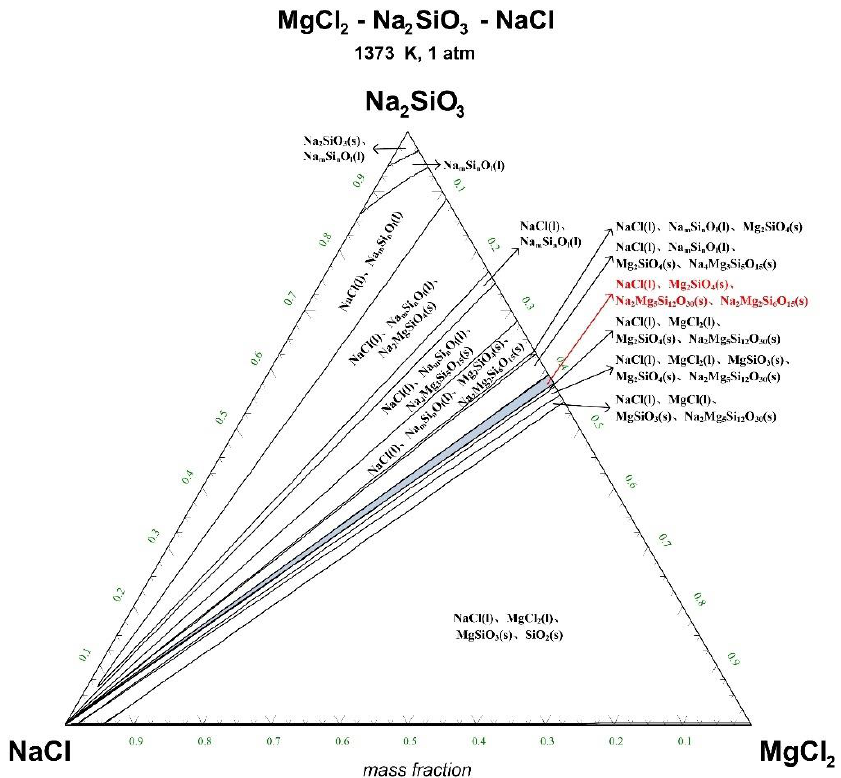
Figure 7. Ternary phase diagram of MgCl 2 -Na 2 SiO 3 -NaCl system at 1373 K. (l — liquid; s — solid). There are 10 – 20 wt% MgCl 2 in typical molten salt chloride slags. When the temperature is 1073 K, liquid MgCl 2 exists in the molten salt chloride slags, shown in Figure 4. It is difficult to separate MgCl 2 (l) from the liquid product to obtain NaCl(l) at this point. When the temperature rises to 1173 K, there exists a phase equilibrium state where only NaCl is the liquid product and the rest are sodium-magnesium silicate solid phase products, shown in the blue area of Figure 5. When the temperature rises to 1273 K and 1373 K, the reaction products of MgCl 2 and Na 2 SiO 3 are similar to the products produced at a temperature of 1073 K, shown in the blue area of Figures 6 and 7. The thermodynamic phase equilibrium shows that Na 2 SiO 3 can react with molten salts containing Mg as an additive. When the temperature is higher than 1173 K, solid- liquid separation can be achieved under suitable conditions (blue area) to obtain the NaCl(l). 4. Phase Transition and Removal Behavior of Magnesium at High Temperature Based on the reaction thermodynamics, the phase diagram of MgCl 2 , NaCl, and additive Na 2 SiO 3 in salt chloride slag was analyzed in this study, and the pure reagent NaCl-MgCl 2 was used to conduct high-temperature phase transformation experiment to simulate molten salt system. The high temperature solid phase transition and solid-liquid separation of MgCl 2 were investigated by varying the experimental conditions. The effect of different experimental conditions on the removal of Mg 2+ was investigated. The optimal conditions for impurity removal were determined experimentally. 4.1. Additive Dosage The mass content of MgCl 2 in raw materials is 10%. When the temperature was 1173 K, the X-ray diffraction pattern of filtrate obtained with different dosage of additives was shown in Figure 8. The effect of varying the amount of additives on the phase transition of the reaction products was analyzed.